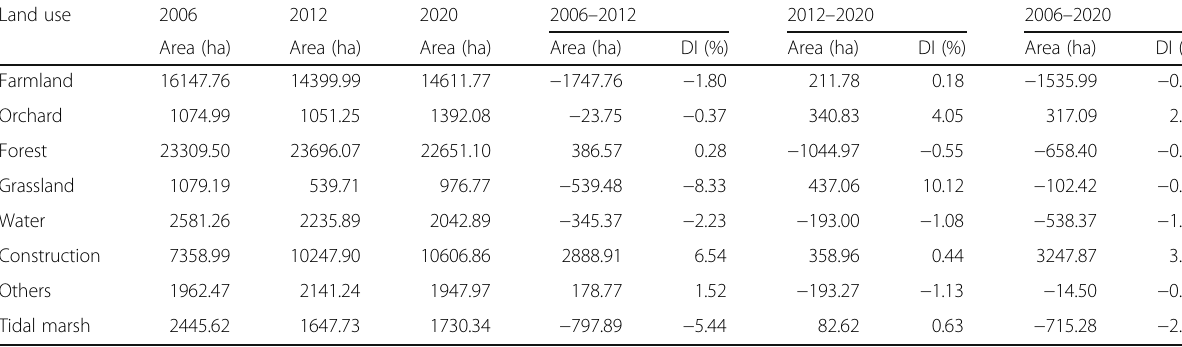
Table 6 Changes in total land use area and dynamic index (DI) Land